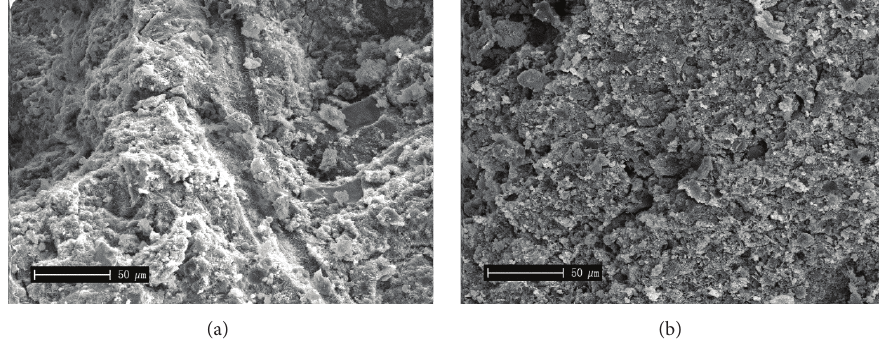
Figure 11: SEM images of microstructure of (a) CFRC and (b) PC concrete exposed to 600 ∘ C for 4 h (1000x